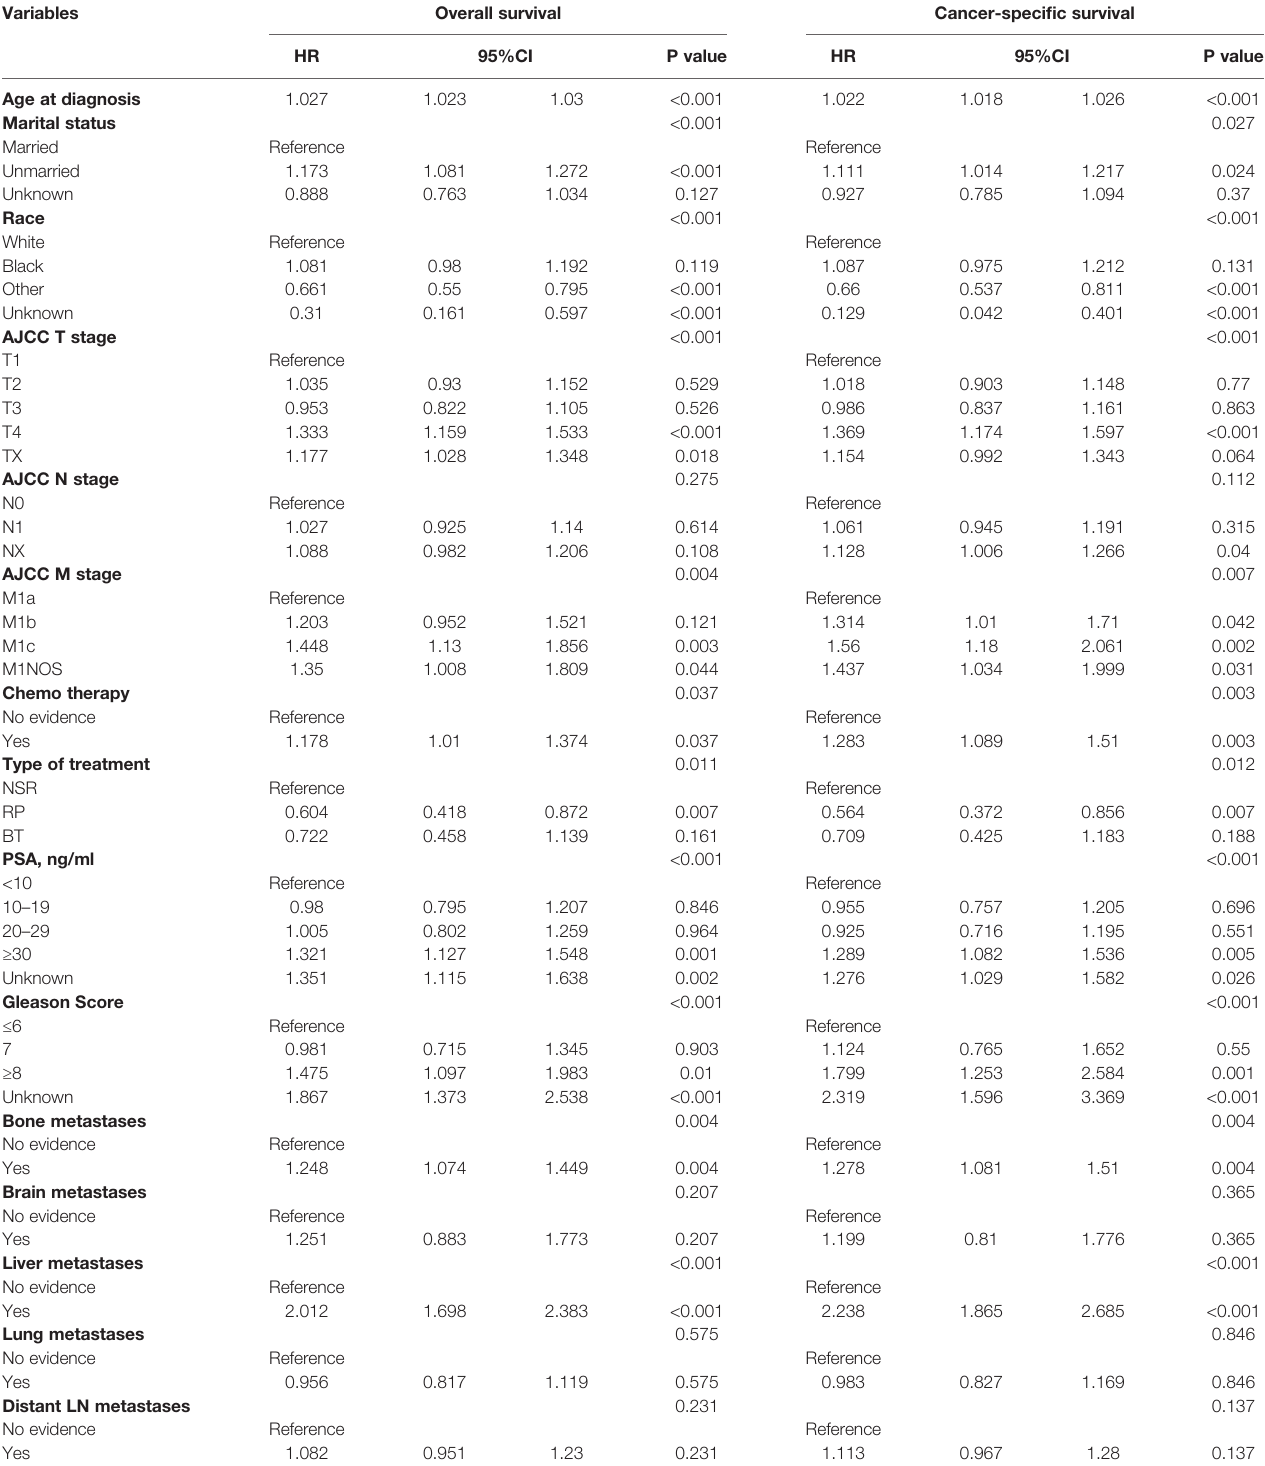
TABLE 2 | Cox multivariate analyses of prognostic indicators for OS and CSS in the overall cohort. Variables Overall survival Cancer-speci fi c survival HR 95%CI P value HR 95%CI P value Age at